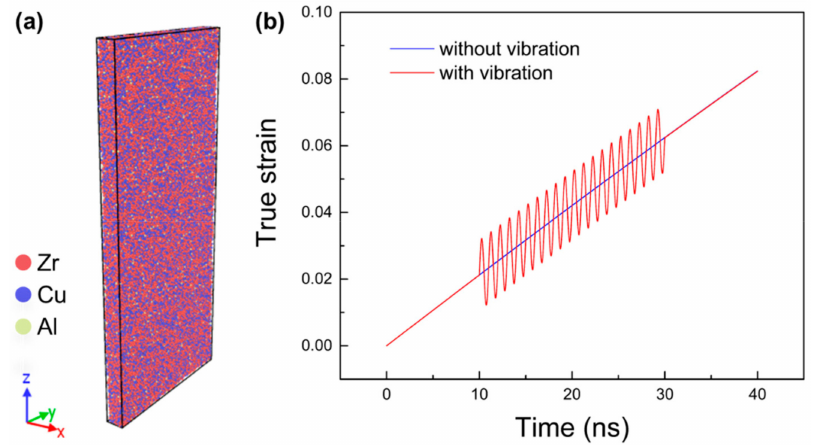
Figure 1. ( a ) Zr50Cu46Al4 MG model and ( b ) motion control curve used in molecular dynamics (MD)